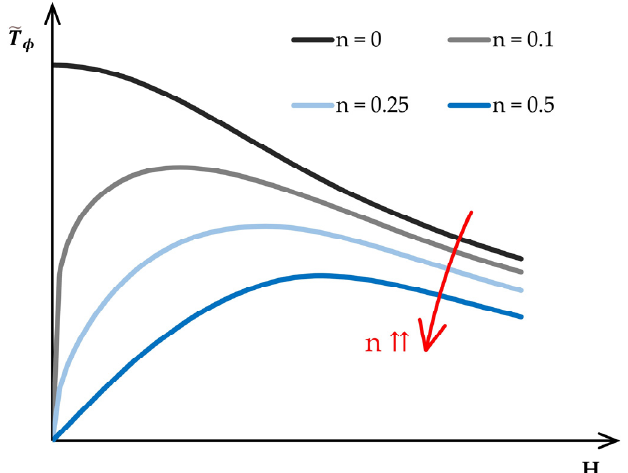
Figure 7. Influence of material strain hardening on the evolution of the normalized force per unit of length with the groove depth.